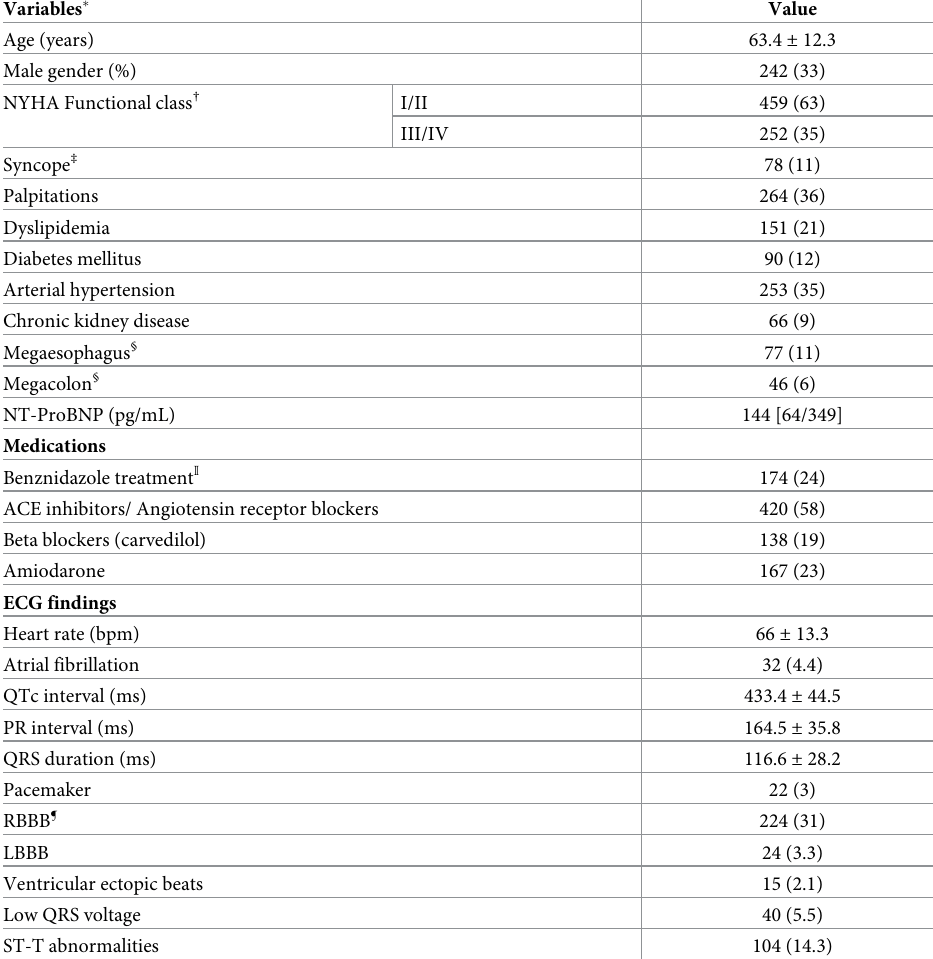
Table 1. Characteristics of the study population (n =